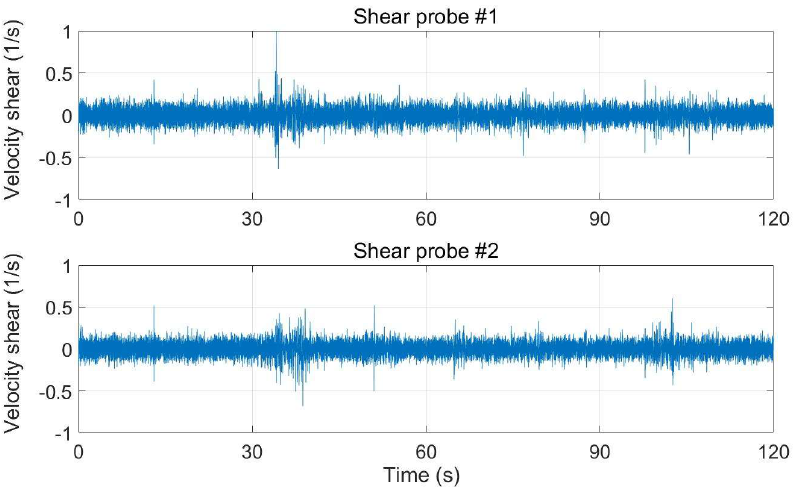
Figure 8. Measured time series of the velocity shear.